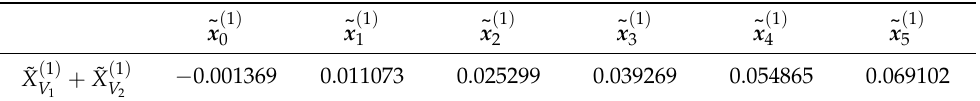
Table 8. The reconstructed series of the marker M 1 composed of the signal components.